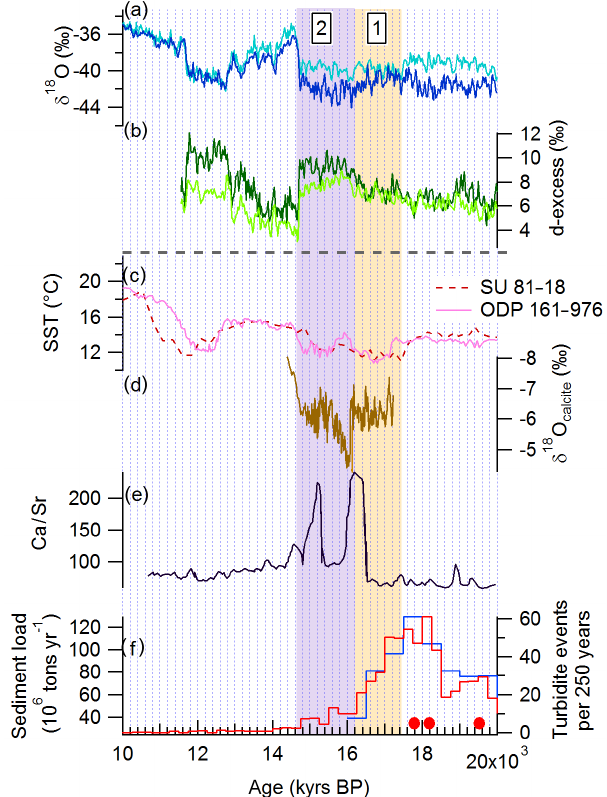
Figure 3. The sequence of phase 1 and phase 2 of Heinrich Sta- dial 1 identified in Greenland records and in proxy records of North Atlantic SST, IRD events, and changes in East Asian hydrocli- mate. (a) NGRIP (dark blue) and GRIP (light blue) δ 18 O records; (b) NGRIP (dark green) and GRIP (light green) d-excess records; (c) sea surface temperature (SST) for North Atlantic cores SU 81-18 (Bard et al., 2000) and ODP 161-976 (Martrat et al., 2014); (d) cal- cite δ 18 O of Hulu Cave (China, Zhang et al., 2014); (e) Ca / Sr from site U1308 in the IRD belt (Hodell et al., 2019) as a signature from strong iceberg discharges from the Laurentide ice sheet; (f) indi- cations for Channel River sediment load (blue, sediment load; red, turbidite frequency) (Toucanne et al., 2010, 2015) as a signature for meltwater input from the European side. The three red circles in- dicate plumite layers resulting from outburst floods on the eastern Canadian margin (Leng et al., 2018), i.e., meltwater arrival from the North America side in the absence of strong iceberg discharge. The dashed horizontal line separates the ice core records reported on the GICC05 timescale from non-ice-core records displayed on their own